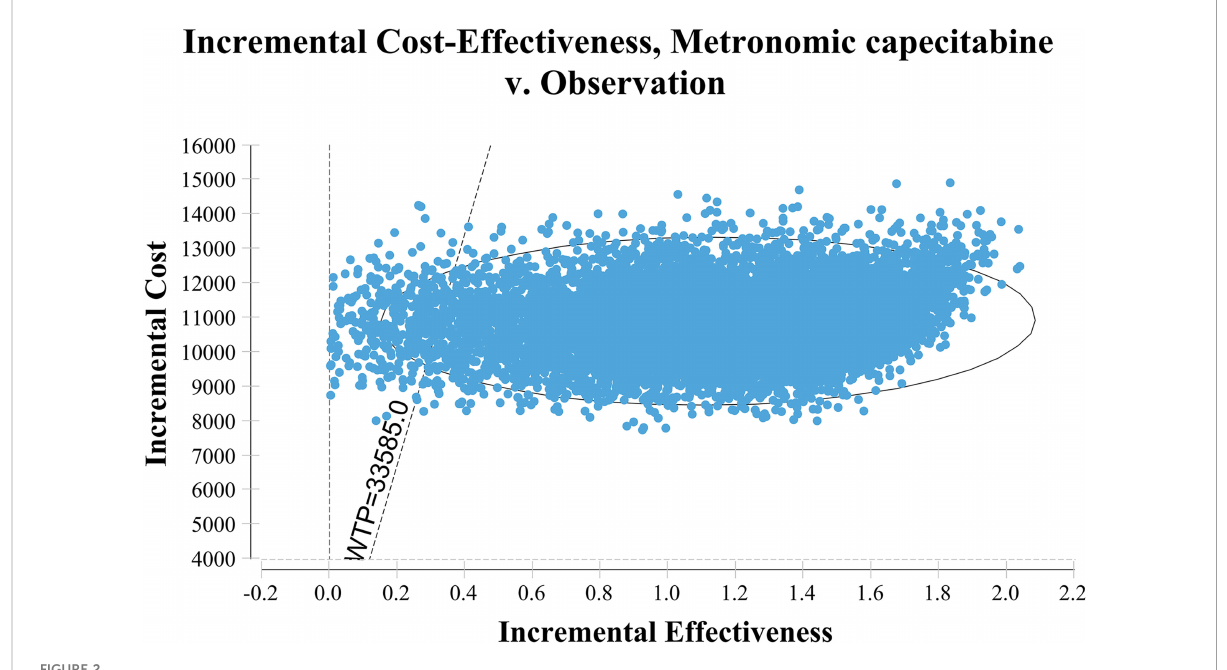
FIGURE 2 The results of probabilistic sensitivity